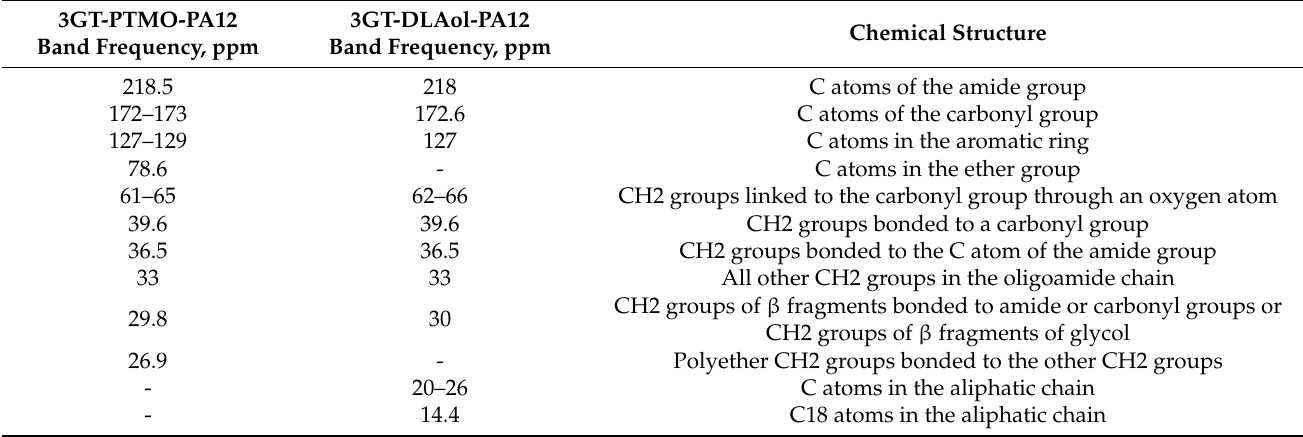
Figure 6. 13 C nuclear magnetic resonance (NMR) spectra of terpolymer 3GT-PTMO-PA12. Table 3. Chemical shifts (ppm) of terpoly(ester-ether-amides) and Table 3. Chemical shifts (ppm) of terpoly(ester-ether-amides) and terpoly(ester-aliphatic-amides).